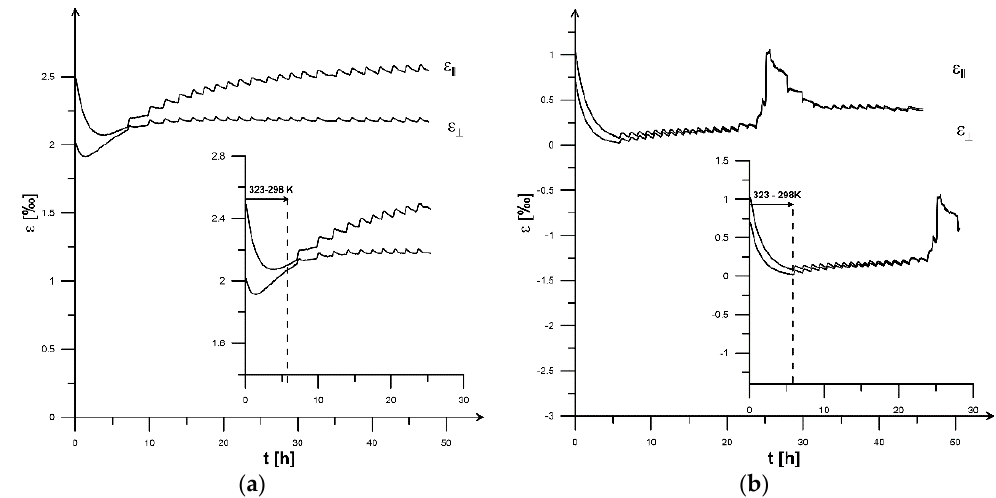
Figure 4. Kinetics (in the direction parallel ε ┴ and perpendicular ε ‖ to the bedding plane) of the coal sample linear strain during temperature decreases for ( a ) CO 2 and ( b ) CH 4 .